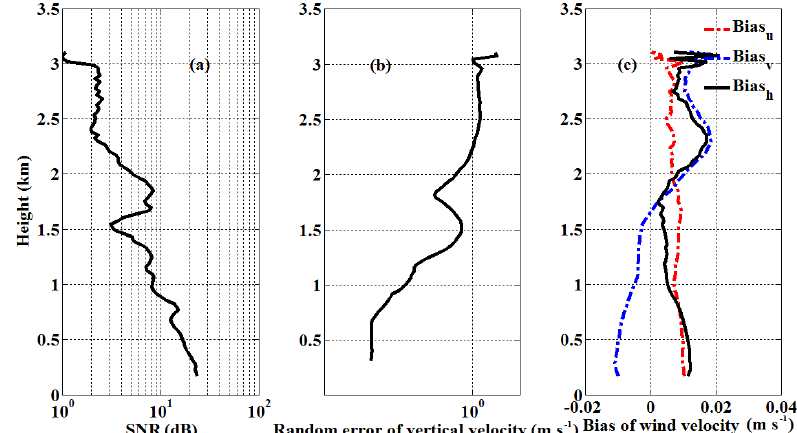
Figure 14. The averaged profile of (a) SNR, (b) Random error of vertical velocity, (c) bias of horizontal wind north-south component ( u ), east-west component ( v ), and horizontal wind velocity ( h ) measured by CDL from 15:52 to 16:02LT on 9 May 2014.